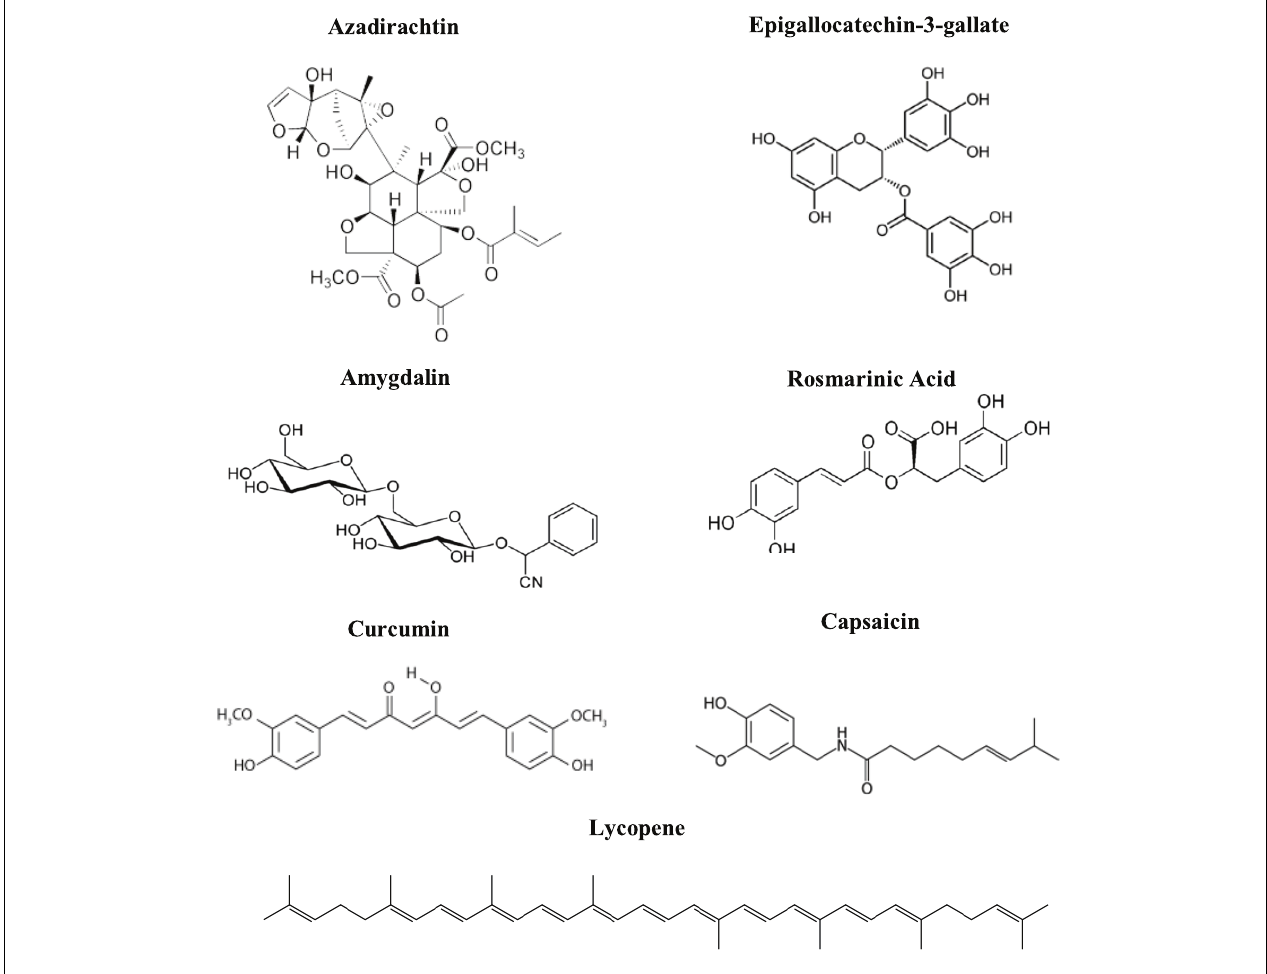
FIGURE 1 | Structural examples of phytochemicals with known or suspected medicinal properties such as antioxidant, antimicrobial, anti-inflammatory, and anti-cancer activity, likely stemming from protective and defensive roles in their plant